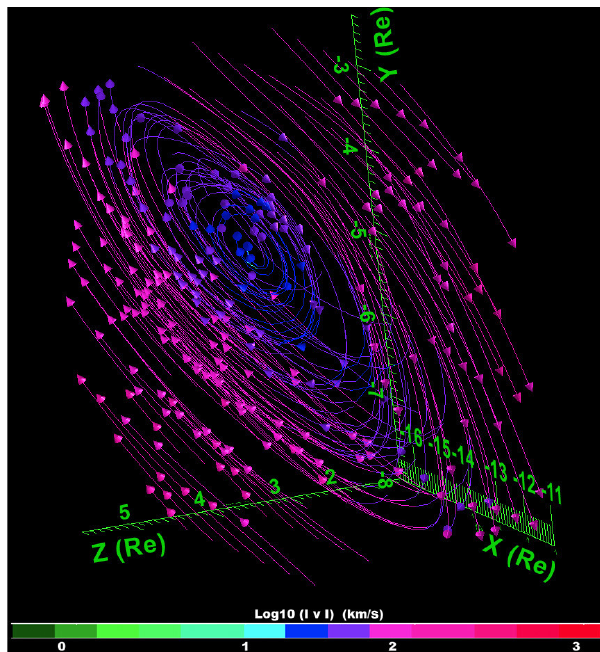
Fig. 10. Dawn vortex of the previous study case from Collado-Vega et al. (2007) of 30 March 2002, 00:40UT, that was found using our automated search algorithm with its rotation axis closely aligned with the x